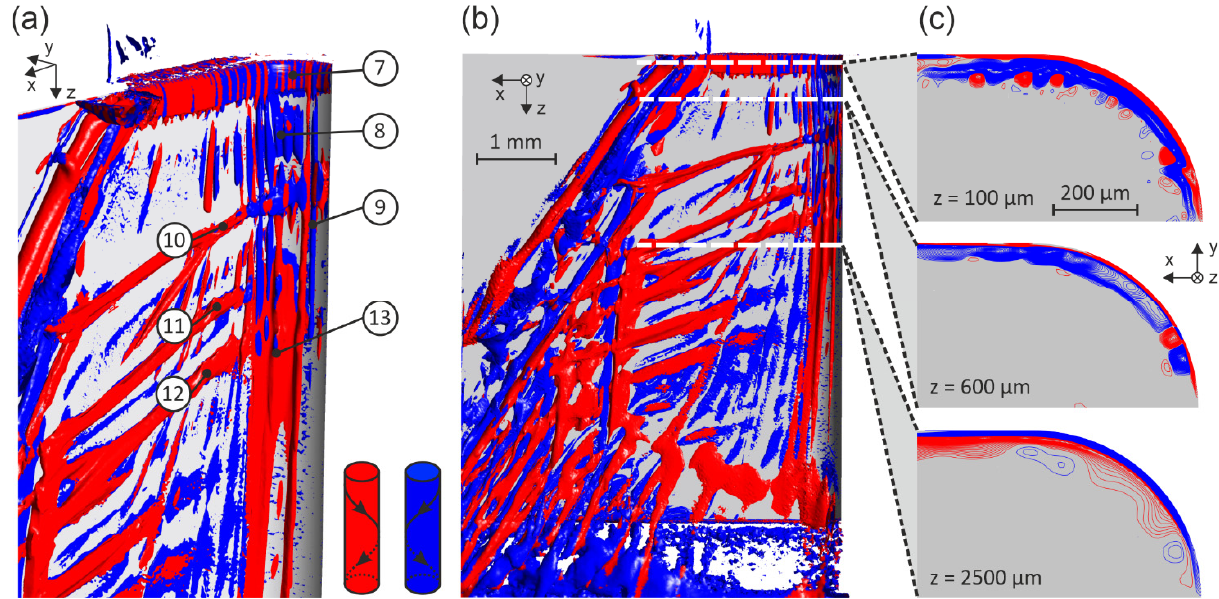
Figure 4. Vortex visualization by means of isosurfaces of λ 2 criterion for λ 2 = − 4.89 × 10 9 s − 2 , colored by z-component of vorticity. Blue areas indicate right-handed and red left-handed vortex cores. ( a ) Detailed view of the upper front at an angle from behind. ( b ) Overall view of front and kerf edge. ( c ) Vortex visualization on horizontal cross-sections by means of isolines of the vorticity z-component, viewed downwards in flow direction. Blue isolines indicate vortices rotating in the clockwise direction (dextrorotatory, ω z = 7 × 10 4 –1 × 10 7 s − 1 ) and red isolines vortices rotating in the opposite direction (levorotatory, ω z = − 7 × 10 4 –1 × 10 7 s − 1